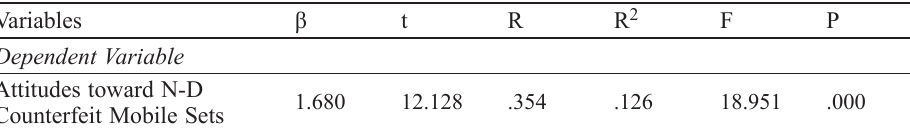
Table 3 . Influences on consumers’ attitudes toward N-D Counterfeit mobile sets and their Purchase